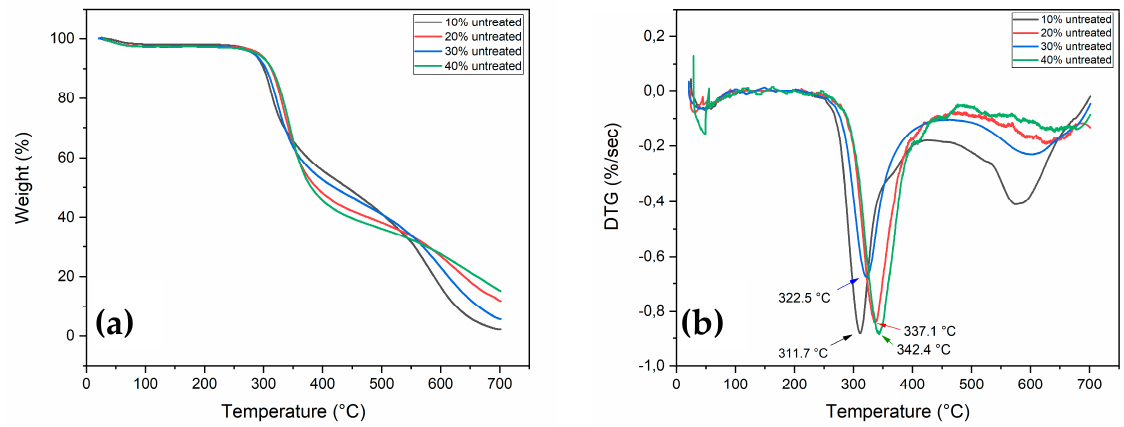
Figure 5. ( a ) TG curves for untreated TVF composites; ( b ) DTG curves for untreated TVF composites.